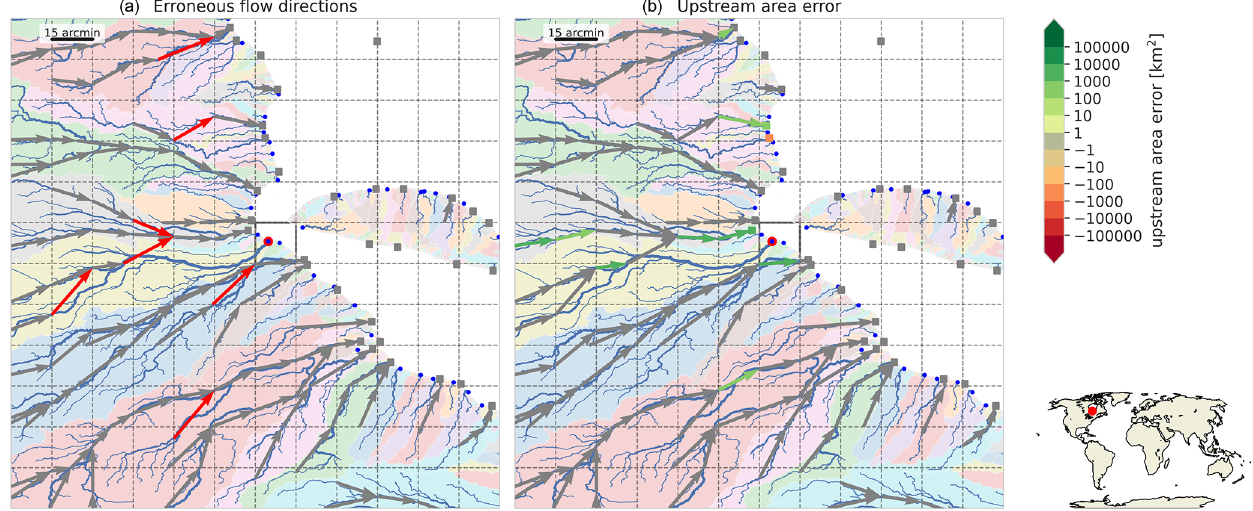
Figure C2. Largest exorheic basin (6830km 2 ) which is not resolved at the 15arcmin resolution indicated with a highlighted basin outlet. See the caption of Fig. C1 for a full